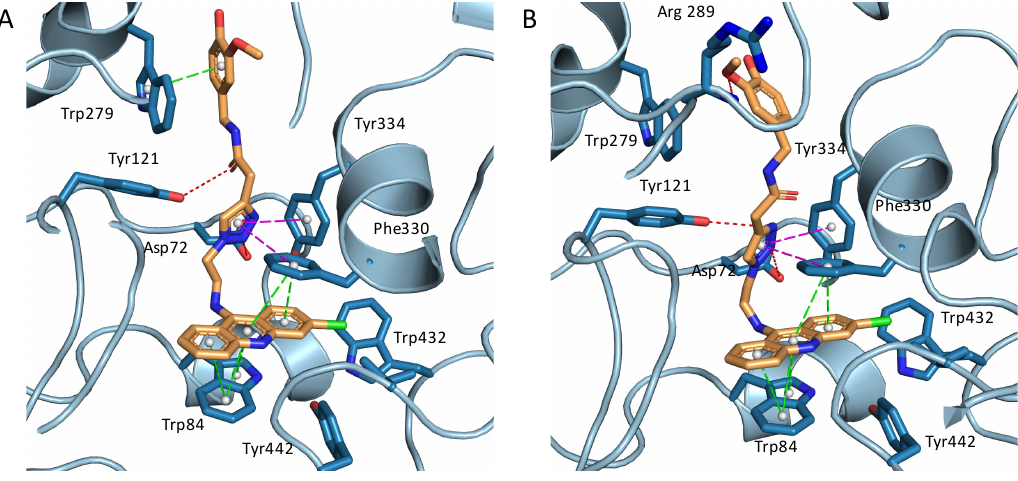
Figure 3. Binding mode of 16 within the active site of Tc AChE in the two copies of the monomer in the asymmetric unit. The binding of the 6-chlorotacrine moiety and of the linker up to the triazole ring are similar. The binding of the phenolic moiety differs. In ( A ), the phenolic moiety is stabilized via a parallel π -stacking interaction, and is thus more stable than in monomer B ( B ), in which only the ether oxygen atom of the phenolic moiety is H-bonded to the main chain nitrogen atom of Arg289. Parallel and perpendicular π -stacking interactions are shown in green and magenta respectively, while H-bonds are depicted in red.